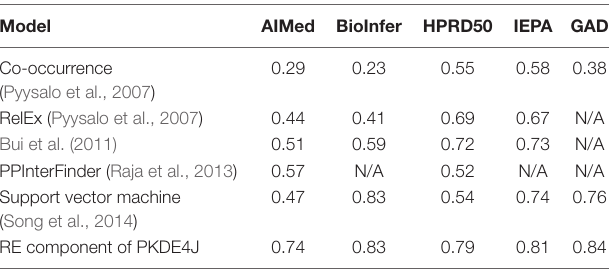
TaBle 6 | Comparative assessment of relation extraction (RE)